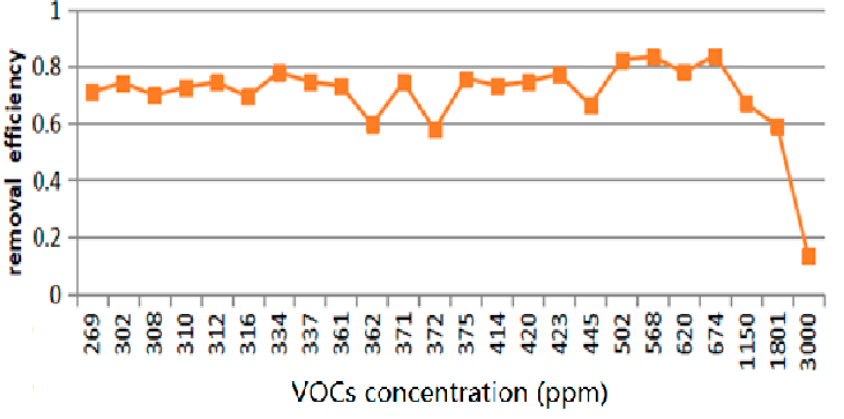
Figure 3. VOC treatment effect of UV photolysis device.